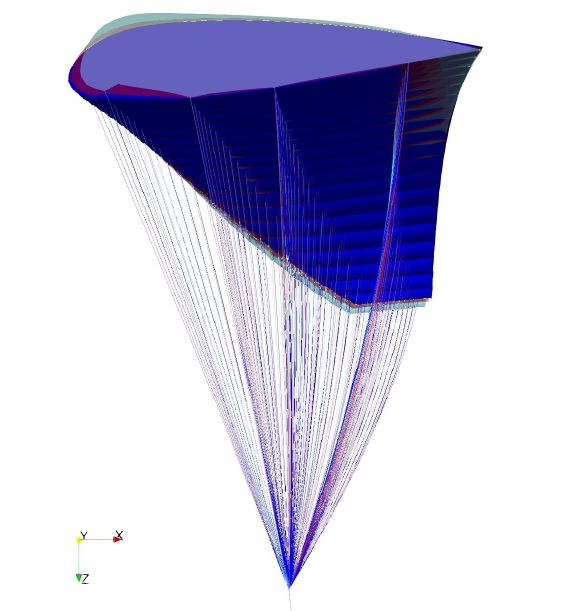
Figure 6. Deformed half-kite in the virtual wind tunnel, for V a = 10, 20, and 30 m/s in blue, red and turquoise, respectively. Adapted from [20].